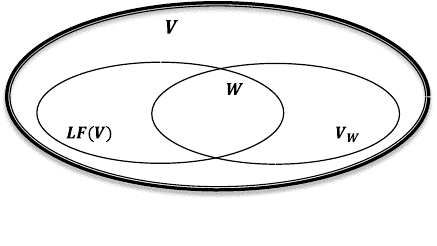
Figure 1. The relationship between composition